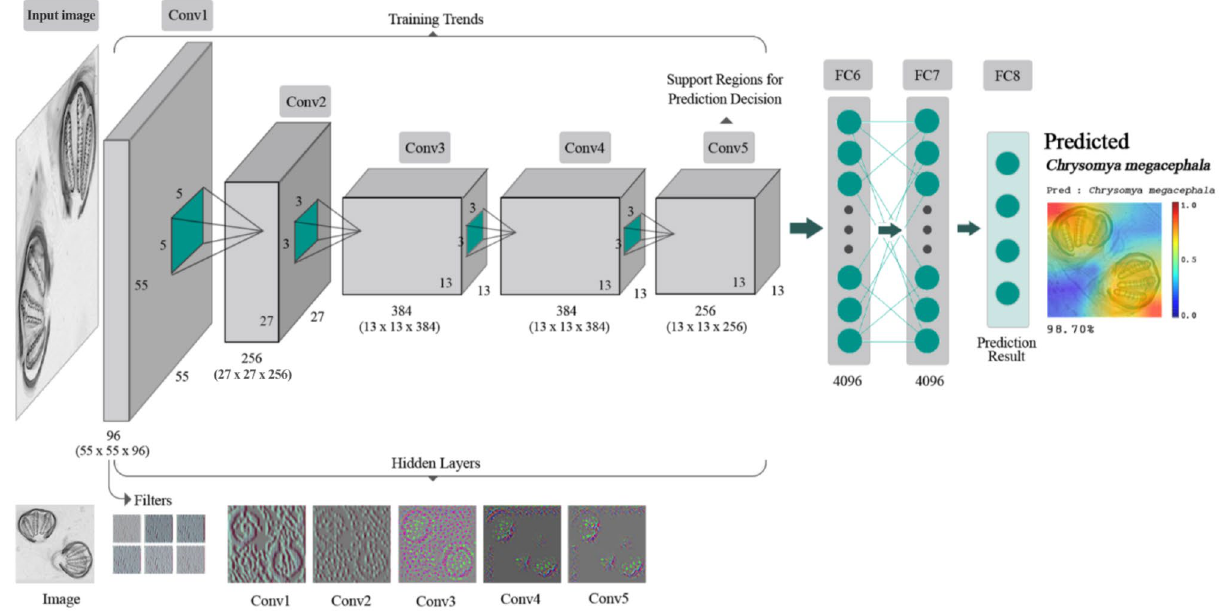
Figure 7. Framework of the proposed interpretation architecture for the deep learning model, AlexNet, in this study. The AlexNet model contains eight learned layers with weights (five convolutional layers and three fully connected layers), namely Conv1 as a convolutional layer that accepts an input image tensor (224 × 224 × 3) and performs Convolution to obtain the position and strength of the input image properties causing tensor output (55 × 55 × 96), Conv2 as a convolutional layer that generates tensor output (27 × 27 × 256), Conv3 as a convolutional layer that creates tensor output (13 × 13 × 384), Conv4 as a convolutional layer that creates tensor output (13 × 13 × 384), Conv5 as a convolutional layer that creates tensor output (13 × 13 × 256), FC6 as a fully connected layer (4096) which flattens tensor output from Conv5 into a single vector by weight sharing, resulting in tensor output (4096 × 1), FC7 as a fully connected layer which performs the same actions as FC6 and generates tensor output (4096 × 1), and FC8 as a fully connected layer to generates tensor output (1000 × 1) which is the prediction result and which contains 1000 neurons corresponding to the 1000 natural image